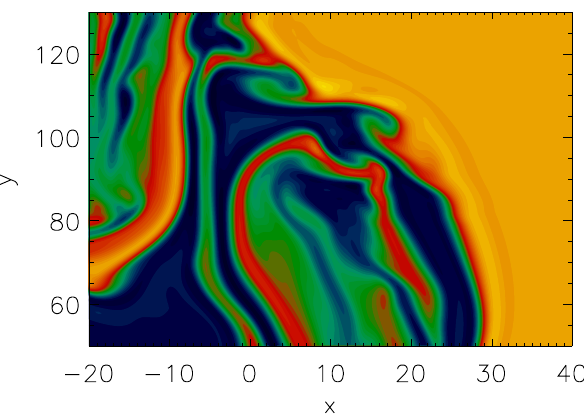
Fig. 6. Shaded density isocontours at t = 350, V 0 = 4 . 6. White curves represent magnetic field lines in the (x,y)-plane. Fig. 7. Passive tracers at t = 370, V